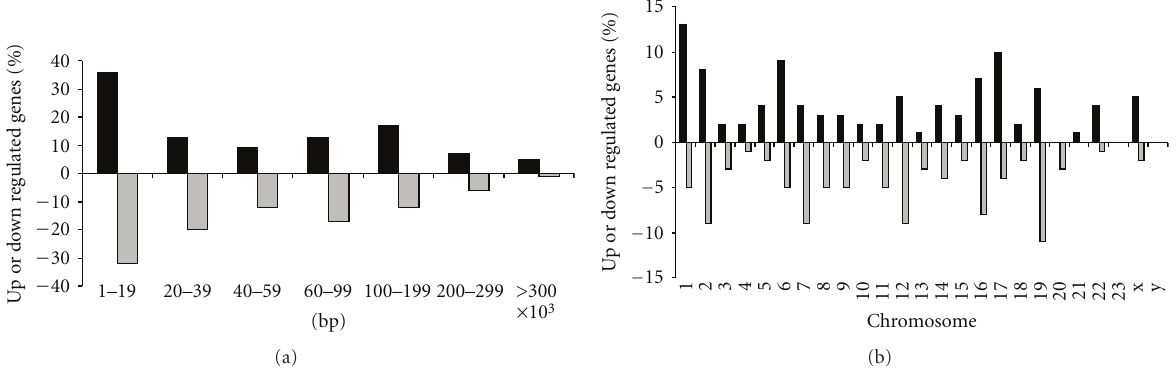
Figure 3: Di ff erences in total gene expressions between non amplified (NA) versus amplified (PA) RNA, regarding (a) sequence length of genes and (b) chromosomal